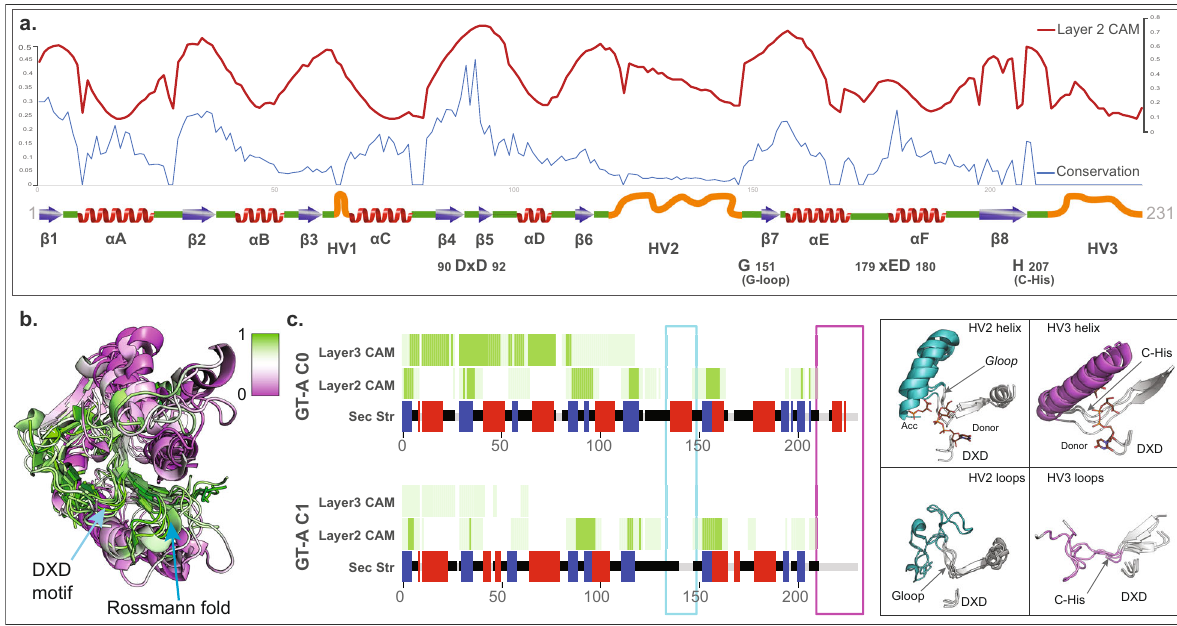
Fig. 3 CAM highlights the GT-A fold core. a The activation values from layer 2 are plotted in red line on top of the conserved secondary structures (blue arrows: beta-sheets; red: helices; green: loops, orange: hypervariable regions) and the conservation scores in blue line. The conservation scores and GT conserved core schematics were collected from ref. 3 . The most conserved regions generally have higher activation values. b CAM values are mapped onto a structural alignment of the GT-A conserved core. The conserved regions are shown to have a high CAM value indicated by high intensity of green and low CAM value by purple. c Left: consensus secondary structure for the aligned positions in the two GT-A fold clusters are shown (blue: beta-sheets; red: helices; green: loops). Average CAM values from layer 2 and layer 3 of the CNN-attention model are shown for each aligned position (higher intensity of green corresponds to a higher CAM value). Cyan and magenta boxes highlight the secondary structure differences between the two clusters near the HV2 and HV3 region respectively. Right: the regions with differences in secondary structure are shown in representative structures from each cluster (GT-A0: GT81 family structures 3ckq, 3o3p, 4y6n; GT-A1: GT6 family structures 5c4b, 5nrb, and GT7 family structures 2ae7, 4lw6) and highlighted in cyan and magenta. The conserved DXD motif, G-loop and C-His are indicated for reference. Donor and acceptor substrates for GT-A0 are shown as sticks. Source data are provided as a Source Data fi